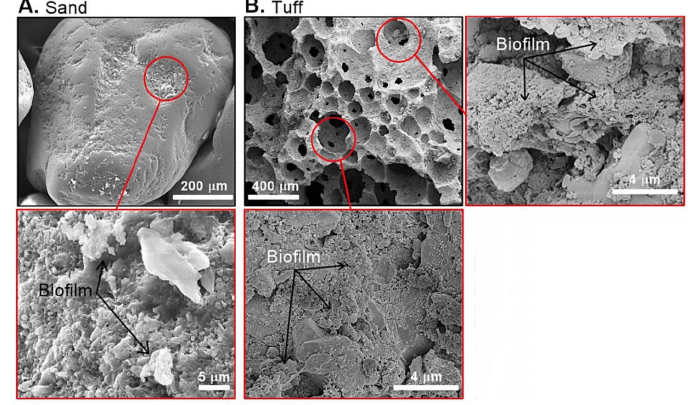
Figure 2. Scanning electron microscope images showing the biofilm presence on a sand grain surface ( A ) and within the canals of a tu ff grain ( B ). All images were taken prior to any